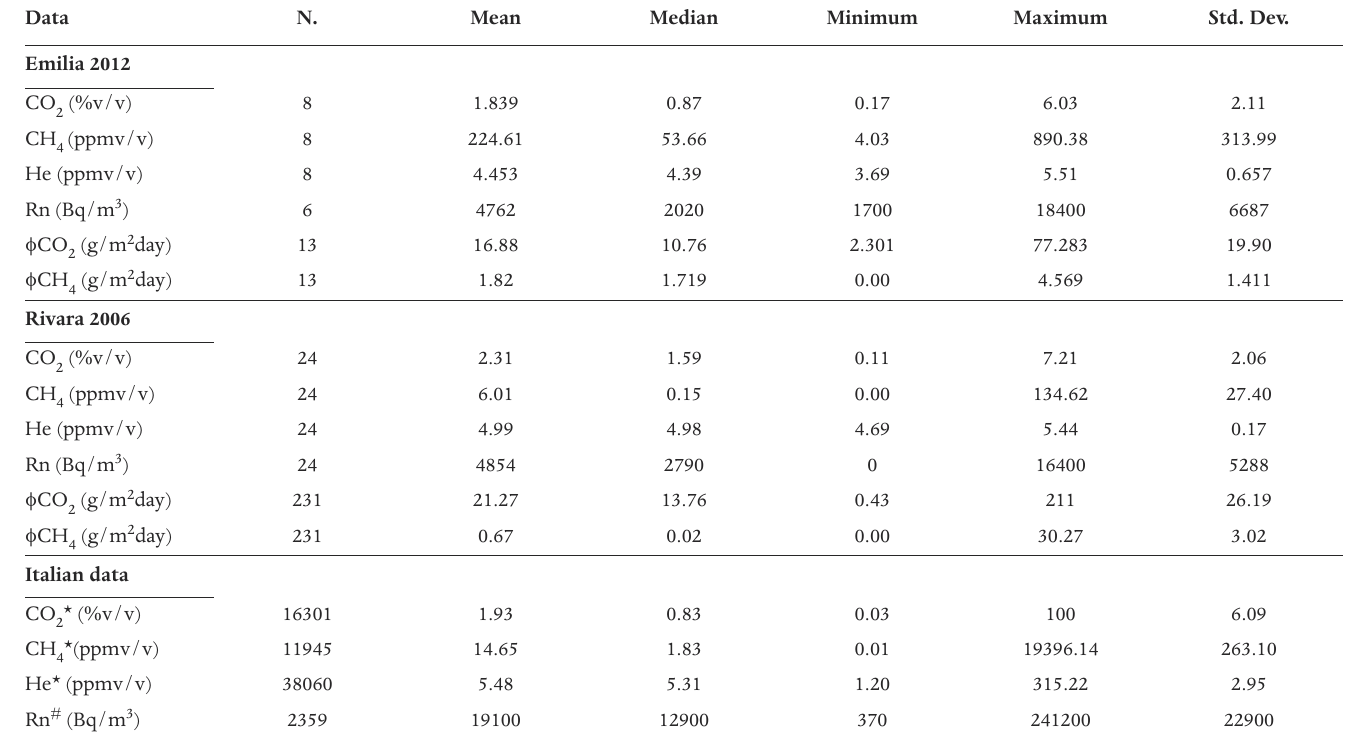
Table 2. Flux and soil-gas statistics for liquefactions and ground fractures in the epicentral area, compared both to previous soil-gas statistics obtained by the authors in 2006 in the area between Rivara and Massa Finalese (Modena) (unpublished data), and to the statistics obtained for two case studies in cen- tral Italy and in foredeep basins. *, soil-gas statistics taken from Annunziatellis et al. [2008]; # , radon data measured in foredeep basins from Ciotoli et al. [2007].